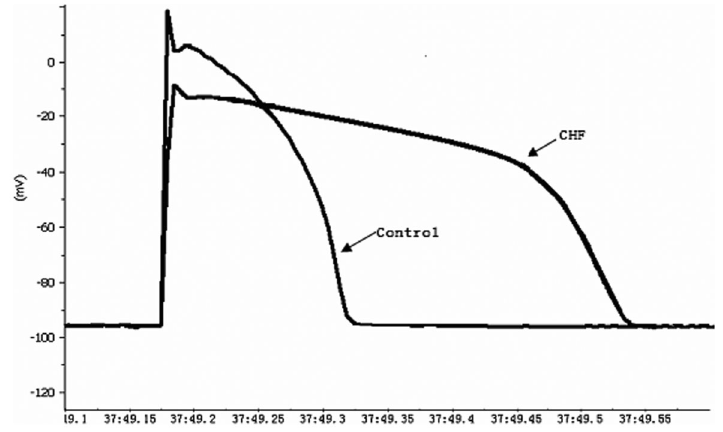
Figure 3. Representative recordings from control and pacing dogs showing action potential shape and duration. CHF: congestive heart